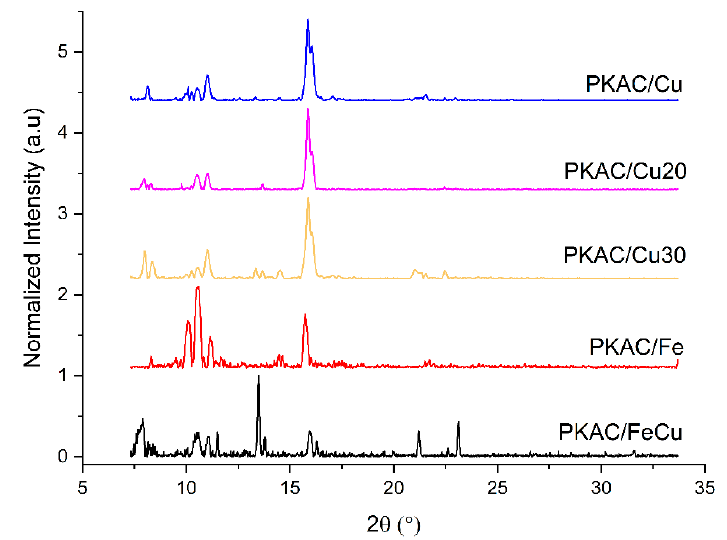
Figure 6. WAXS patterns for monometallic and bimetallic catalysts. The copper species detected on PKAC/Cu, PKAC/Cu20, and PKAC/Cu30 include Cu (at 16 ◦ ), CuO (at 13, 14, 22, and 23 ◦ ), and Cu 2 O (at 15.5 ◦ ) [20], with the latter exhibiting the highest crystallinity. The increment of copper loading saw an increase in intensity, espe- cially for Cu 2 O. Meanwhile, the iron species observable in PKAC/Fe included only Fe 2 O 3